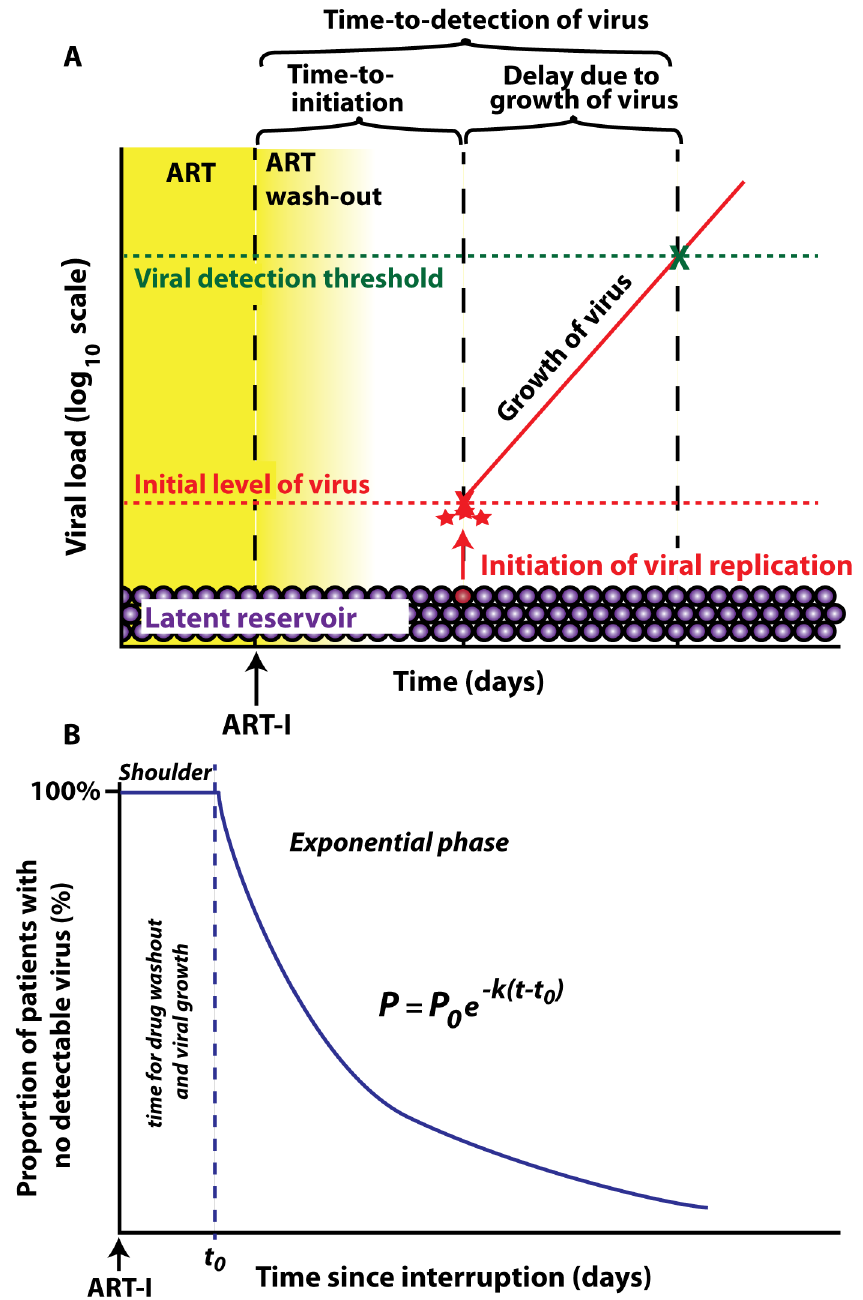
Fig 1. Schematic of viral recrudescence after ART-interruption. (A) After ART-interruption, there is an initial delay when virus cannot grow, due to ‘ washout ’ of ART. Once viral replication is possible, there is a variable time until successful viral replication is initiated from the latent reservoir. The low initial level of replicating virus then increases until it reaches the detection threshold. Time to initiation refers to time until replicative infection commences, which is followed by a delay due to viral growth, and then by detection of plasma virus. (B) time-to-detection plotted as a ‘ survival curve ’ . The initial shoulder occurs due to ART washout and viral growth, and is followed by an exponential decay in the proportion of patients with no detectable virus.